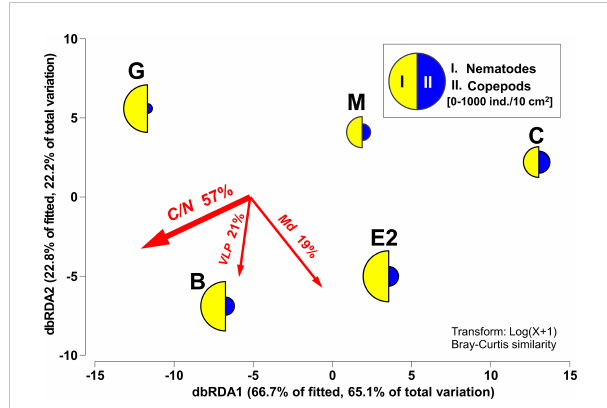
FIGURE 6 dbRDA of meiofaunal community structure according to DISTLM with selected environmental factors. The percentages of variation in the fi tted model and of the total variation in mean abundances of meiofaunal taxa among stations as explained by each of the dbRDA axes are indicated. Mean densities (0 – 3 cm sediment depth) per station of the two most structuring taxa (I. Nematodes, II. Copepods) superimposed as segmented bubble plot. The directions and lengths of vector overlays denote the directions and strengths of the relationships between the dbRDA axes and environmental factors, respectively. C/N: molar basis C/N ratio, Md: median grain size, VLP: Virus-like